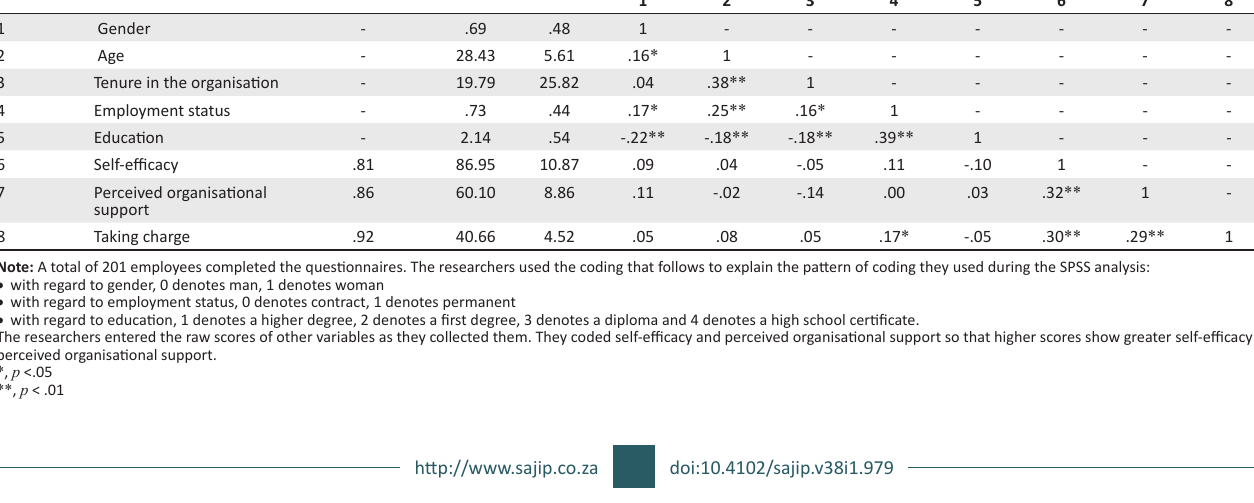
TABLE 1: Means, standard deviations and inter-correlations between study variables. Variable Variable